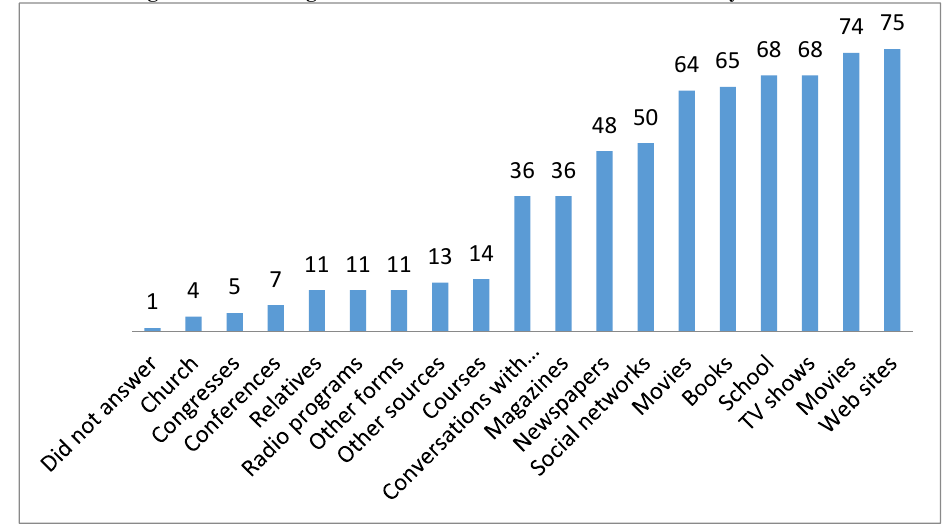
Figure 1: Percentage of each source of information consulted by